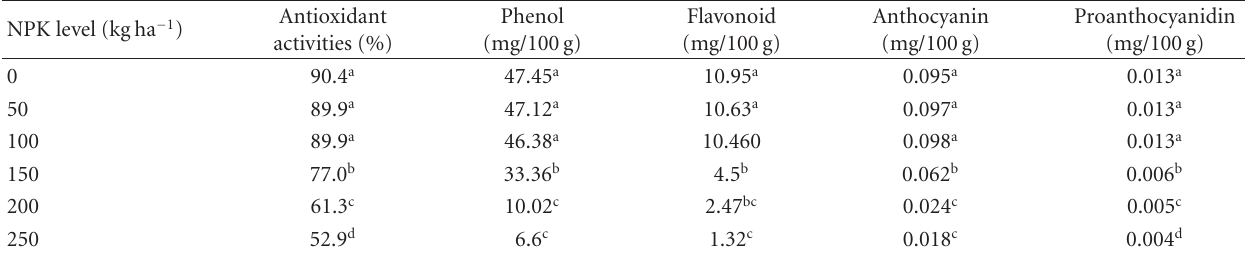
Table 6: Antioxidant activities and its components in Pumpkin seeds as a ff ected by NPK fertilizer.